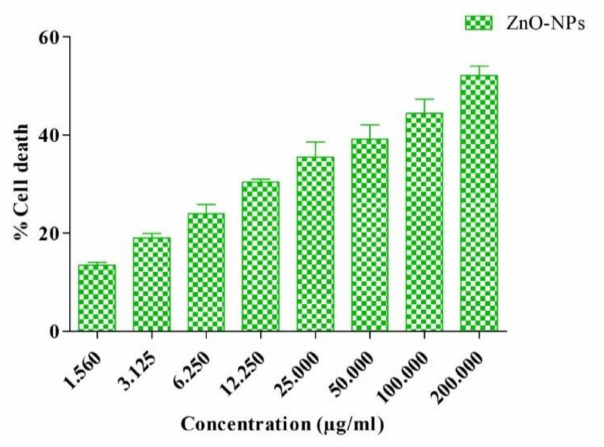
Figure 12. Anticancer effect of ZnO-NPs at a concentration (1.56–200 µ g/mL) on A549